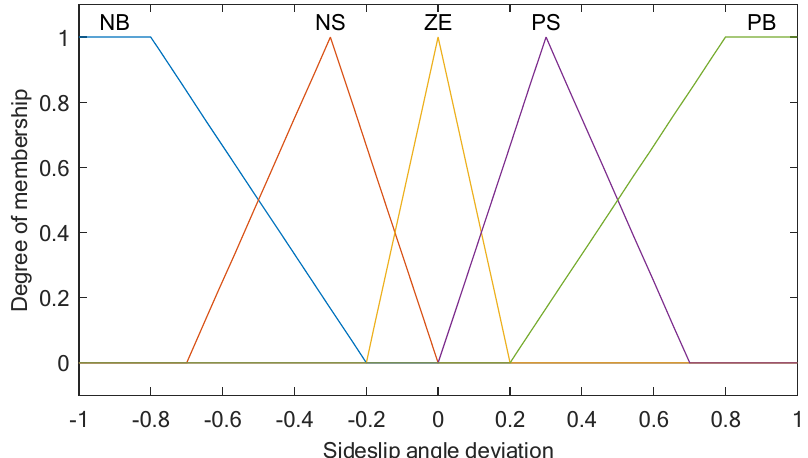
Figure 7. Membership function of the side slip angle deviation.